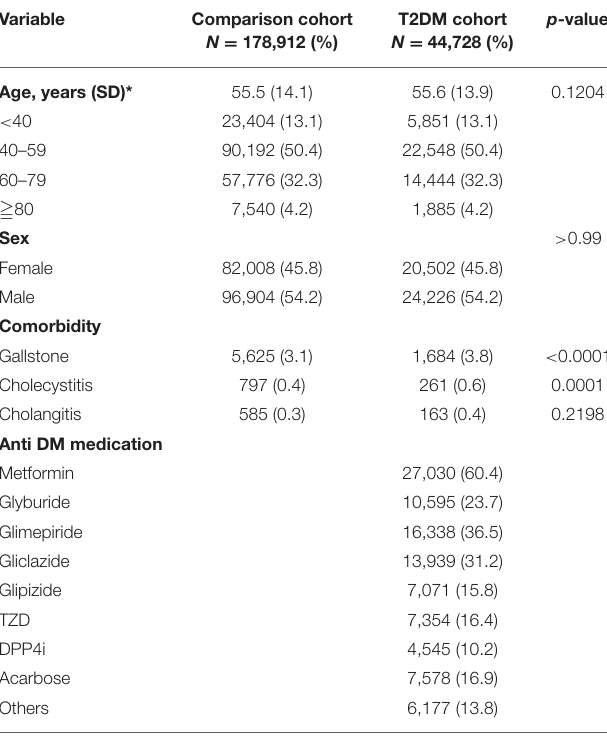
TABLE 1 | Baseline demographic status and comorbidity for comparison and T2DM cohorts.